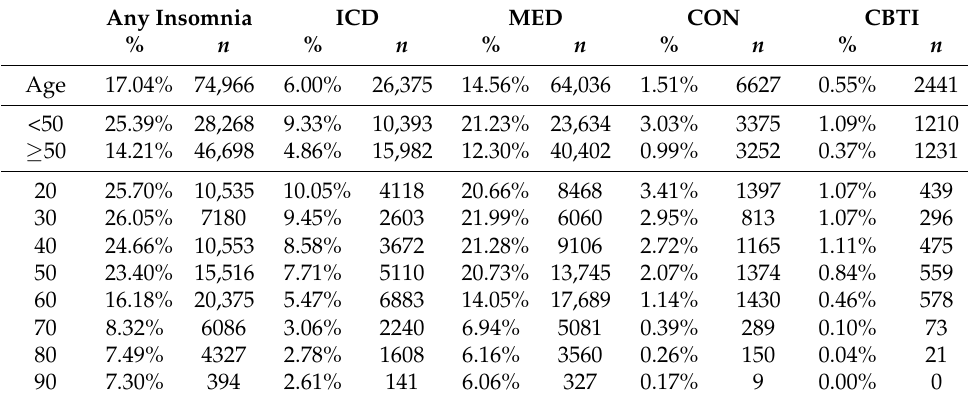
Table 2. Insomnia indicators by age (young vs. old; deciles).